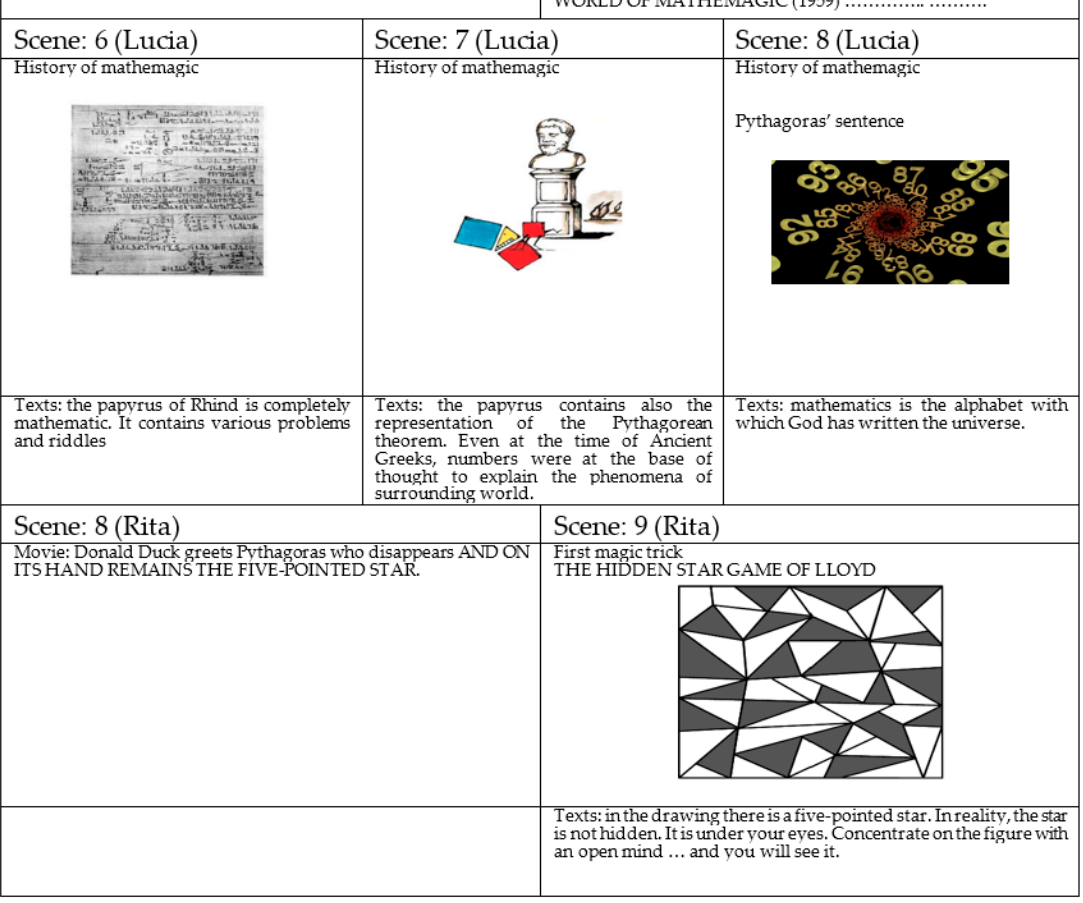
Figure 1. Example, how to create a part of the storyboard template to realize digital